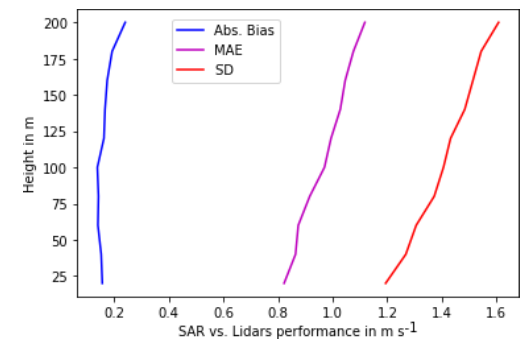
Figure 7. Performance of the machine learning algorithm extrapo- lating corrected SAR surface winds to higher